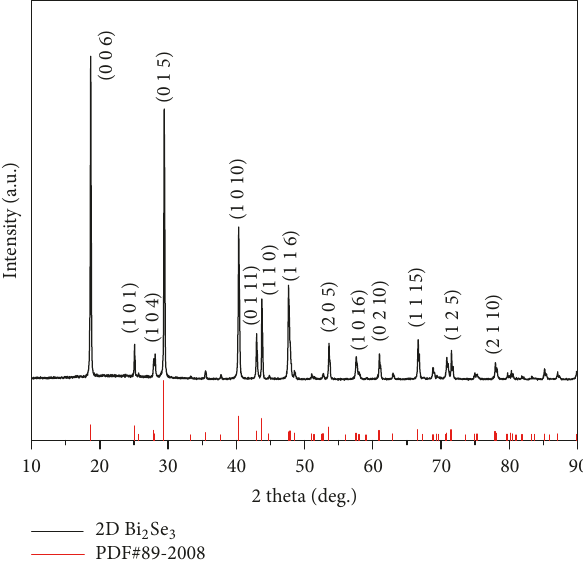
Figure 1: XRD pattern and standard data card pattern of Bi 2 Se 3